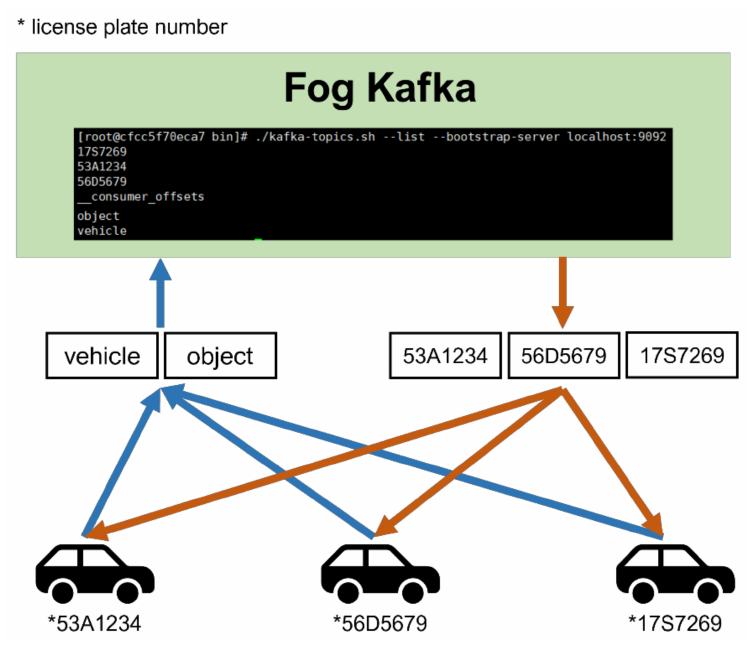
Figure 10. Data topics for edge-fog